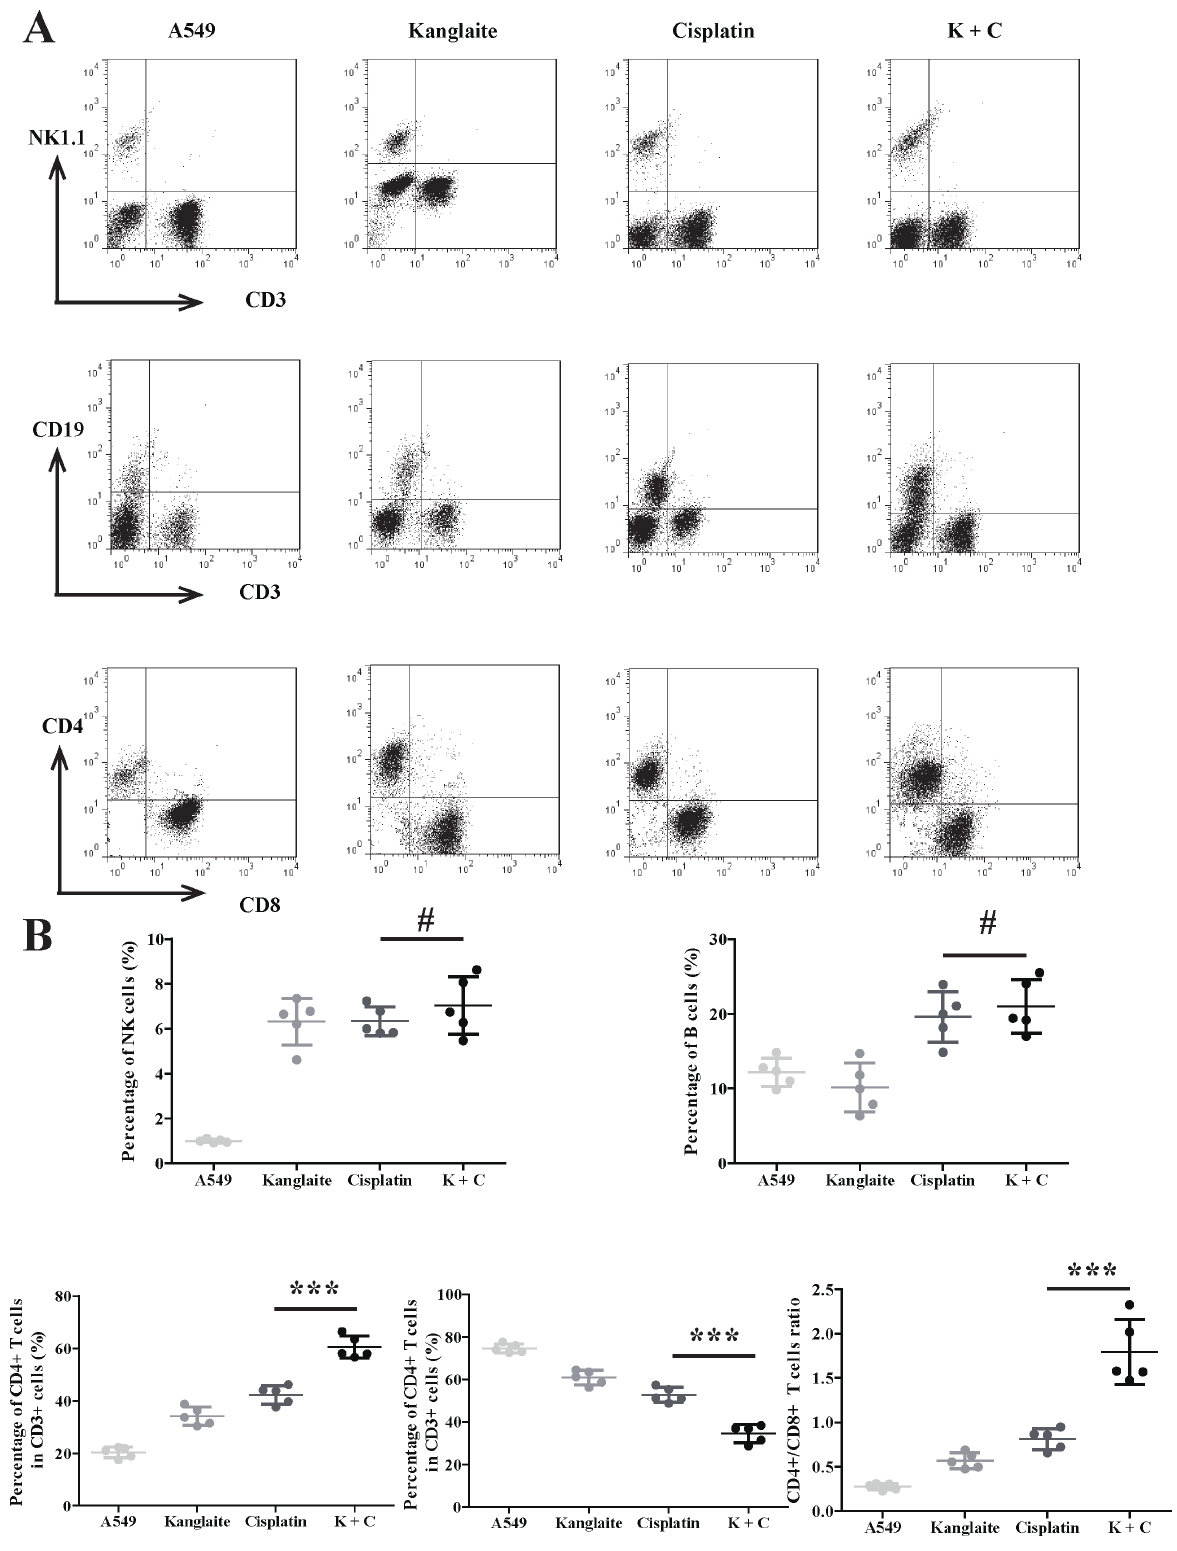
Fig. 2. Effects of Kanglaite on the relative percentages of host lymphocyte subgroups in the blood. (A) The percentages of natural killer cells (CD3-NK1.1+), B cells (CD3-CD19+), CD4+ T (CD3+group and CD4+CD8–), and CD8+ T cells (CD3+group and CD4-CD8+) in the periph- eral blood of mice in each group were determined by flow cytometry. (B) Statistic analysis of natural killer cells, B cells, CD4+ T cells, CD8+ T cells, and CD4+/CD8 + ratio was shown. Data shown as mean with SEM ( n = 5) and # P > 0.05 and *** P <